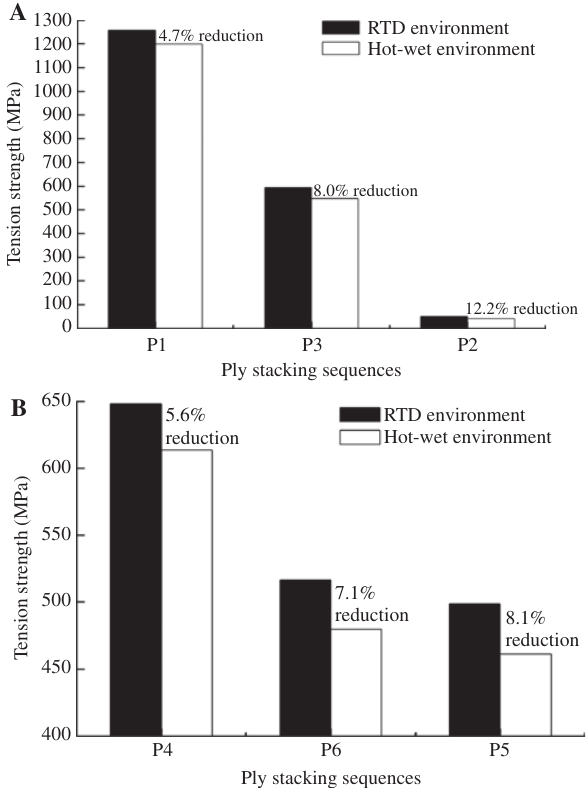
Figure 3: Two kinds of cross sections of [( ± 45)/(0,90)] with